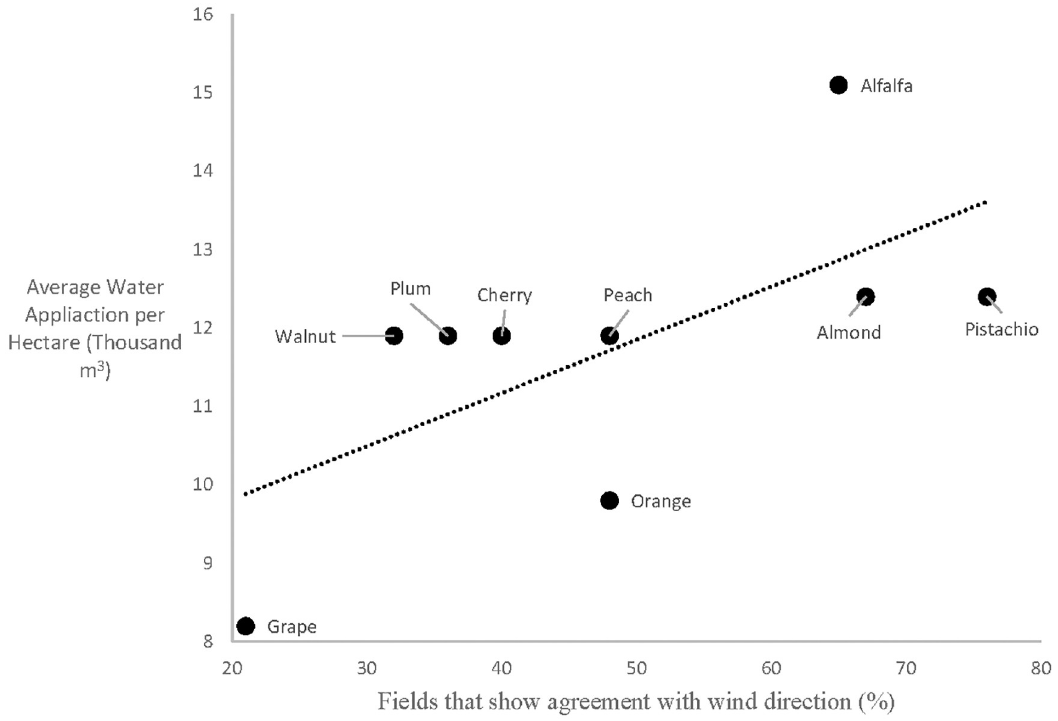
Fig 14. Water vapor trends by crop water use. A positive correlation is found between crops that require higher water inputs and those that show better agreement between water vapor trends and wind direction (y = 0.02x +